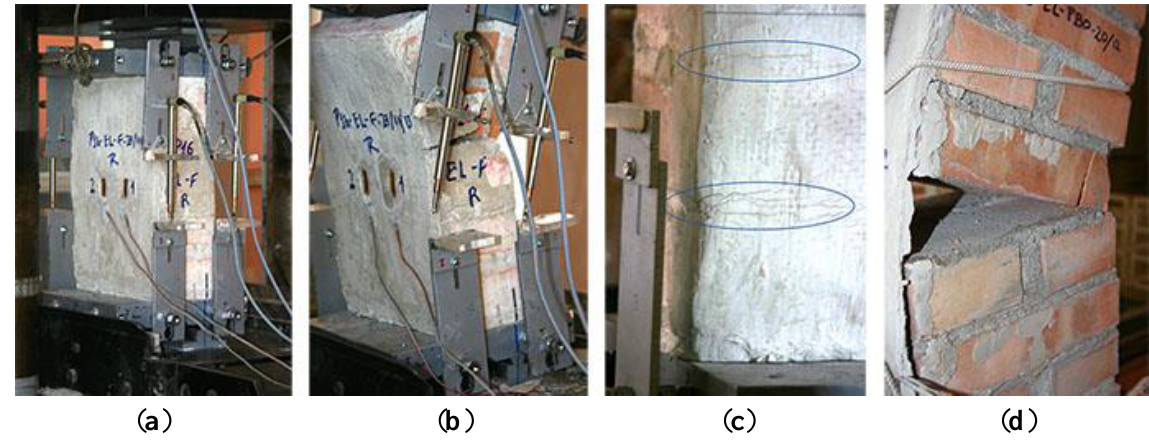
Figure 7. Repaired specimens subjected to axial bending loads: ( a ) specimen strengthened with flax-FRCM composite; ( b ) failure mechanism of the repaired specimen; ( c ) formation of matrix cracks in flax-FRCM composites; ( d ) debonding phenomena observed in specimens strengthened with PBO-FRCM.